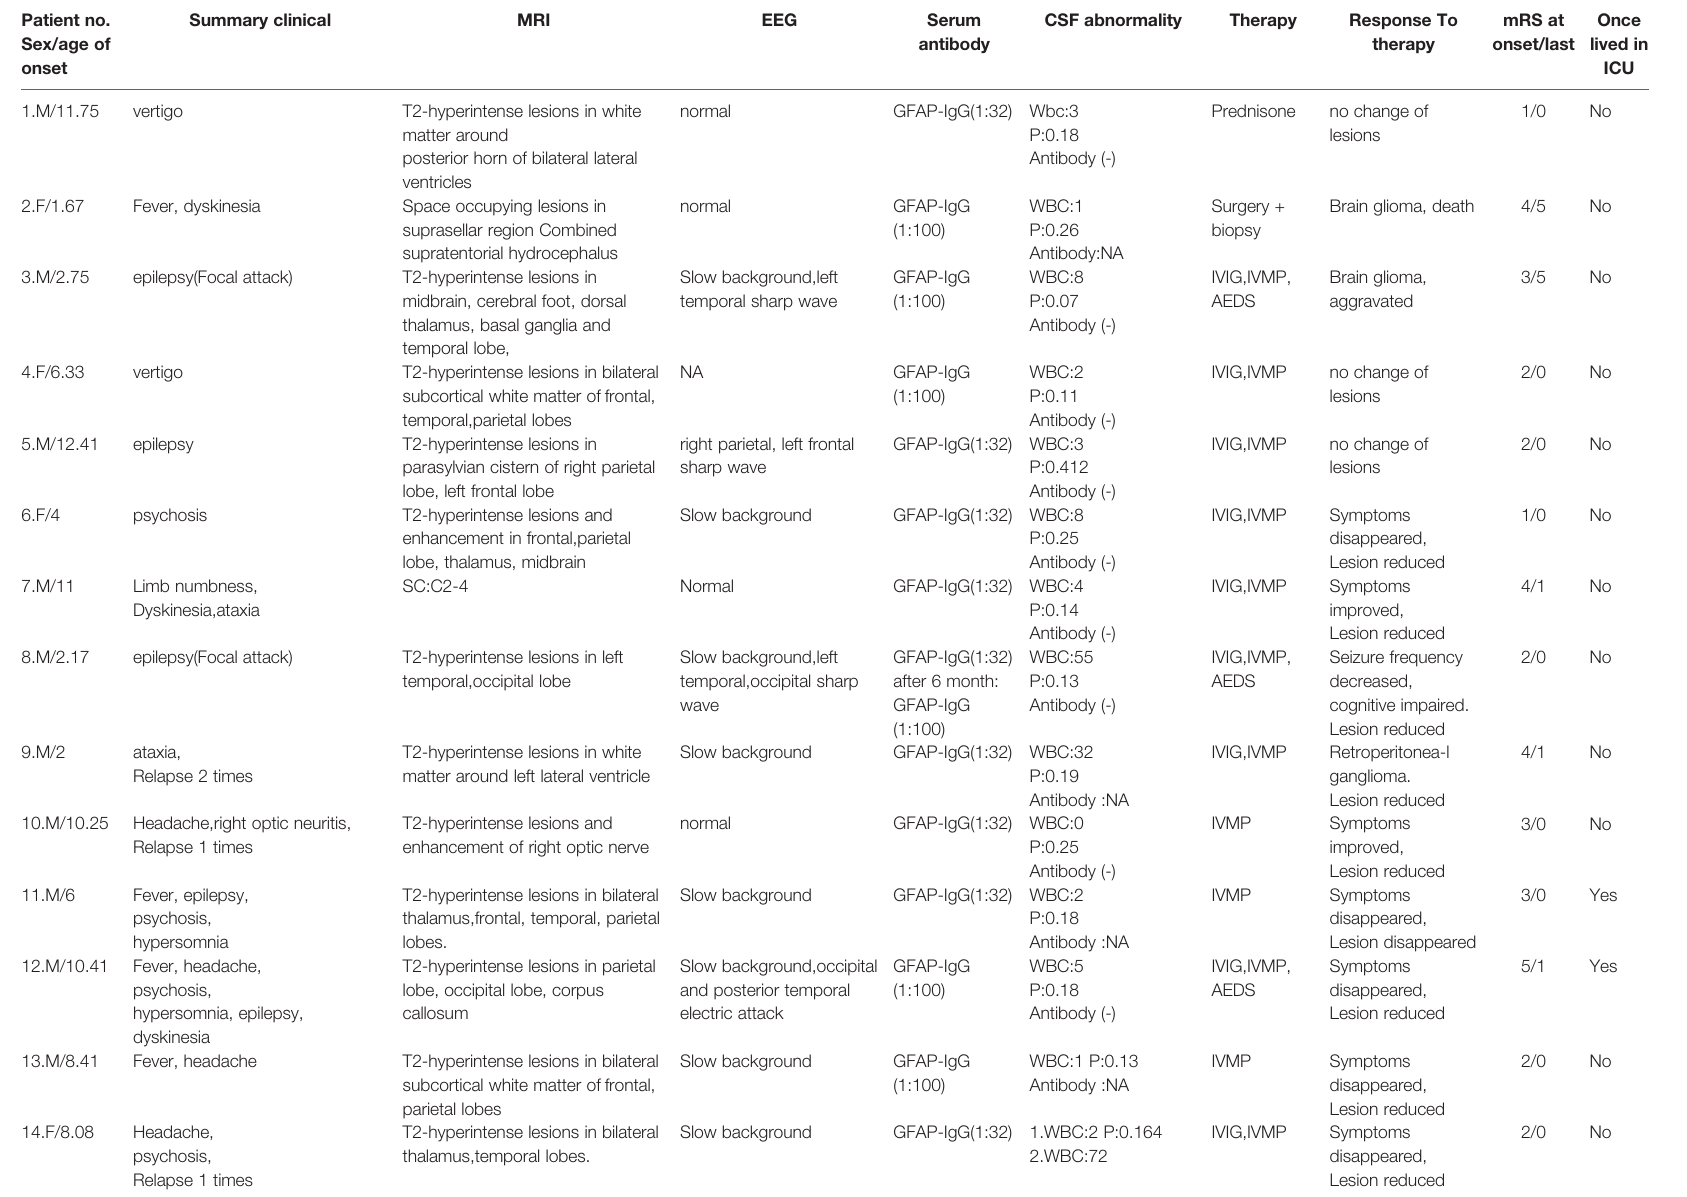
TABLE 1 | Clinical features, auxiliary examinations, diagnosis and treatment strategies, prognosis in pediatric patients positive for GFAP-IgG. Patient no. Sex/age